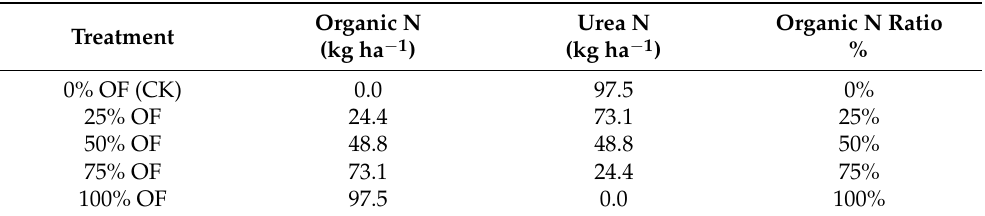
Table 1. The amount of organic and urea N input and the ratio of organic N to total N in different